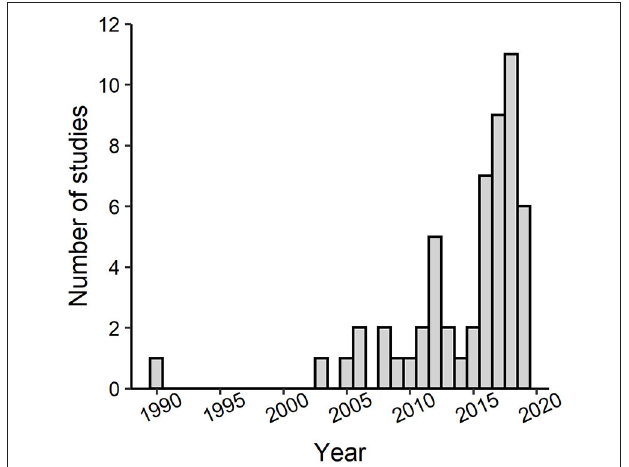
FIGURE 3 | Histogram showing the number of studies produced per year for the past 30 years (each bar represents a single year) that have investigated effects of urbanization on lizard phenotypic traits. The bar associated with 2019 does not include all studies from that year because our literature search was conducted in May of